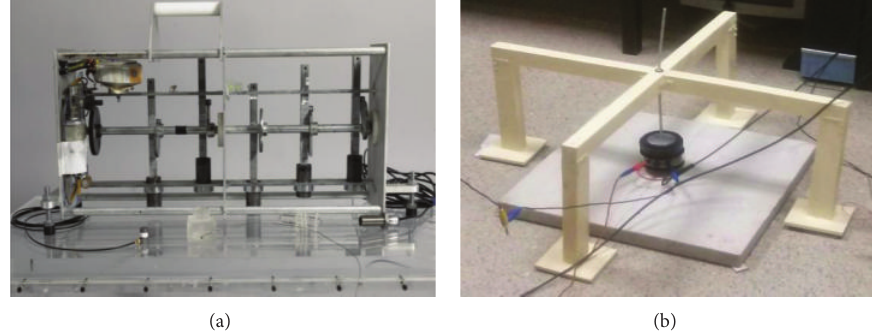
Figure 1: (a) Striking device listed on the UNE EN 140-7. (b) Alternative striking